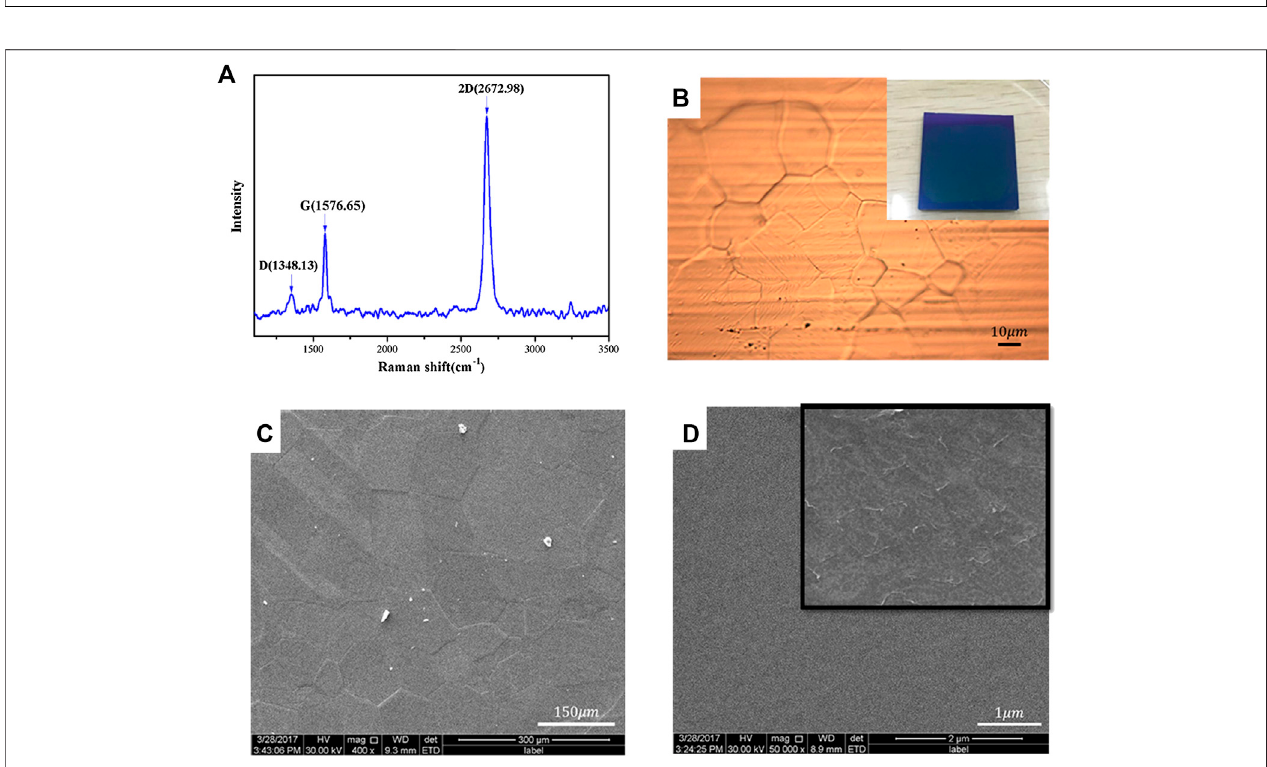
FIGURE 2 | Raman spectrum of graphene transferred onto the silicon substrate (A) and the optical microscope image of copper-based graphene (B) and SEM images of copper-based graphene (C) and the fl attened graphene transferred onto the SiO2/Si substrate (D) .